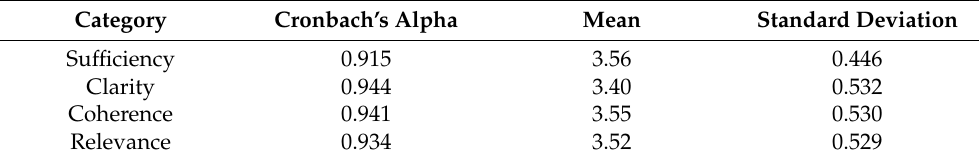
Table 4. Cronbach’s Alpha and descriptive statistics for each of the categories.